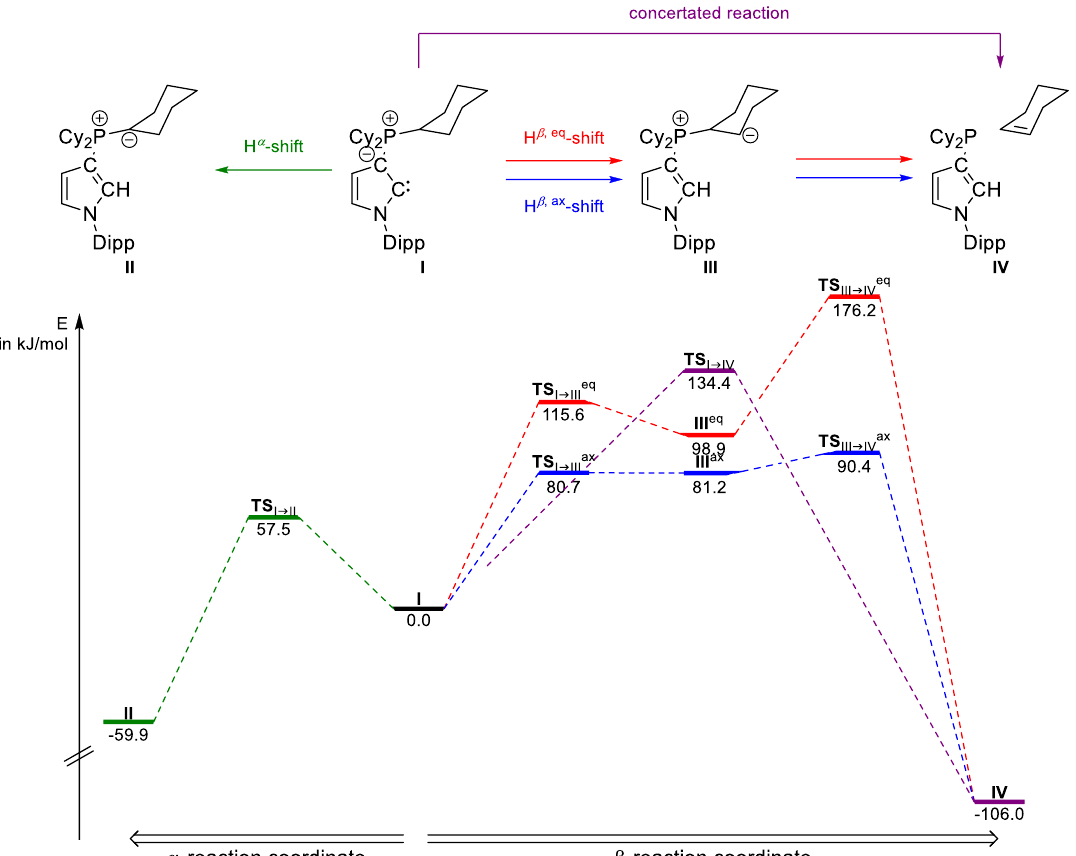
Figure 5. Different pathways for the decomposition of a PCy 3 -substituted CAYC. Energies are given relative to CAYC I (PBE0-def2svp/PBE0-def2tzvp; PCM with THF as solvent).